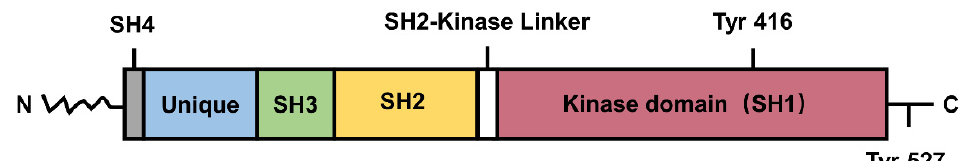
Figure 1. The domain structure of Src family kinases. The chicken numbering system is displayed. 1 SFKs consist of several fields: the SH4 domain (in gray), a unique domain (in light blue), the SH3 domain (in green), the SH2 domain (in orange), and the SH1 domain (in red).